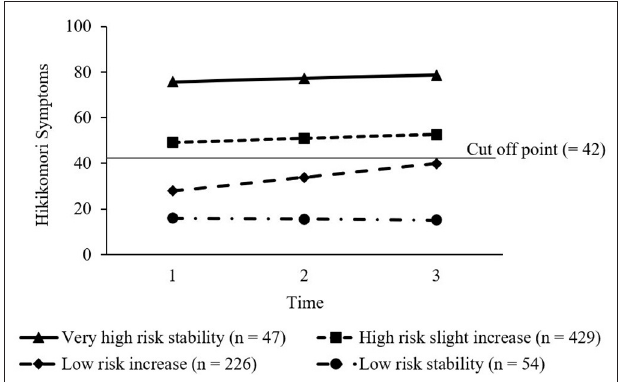
FIGURE 1 | The four trajectories of hikikomori